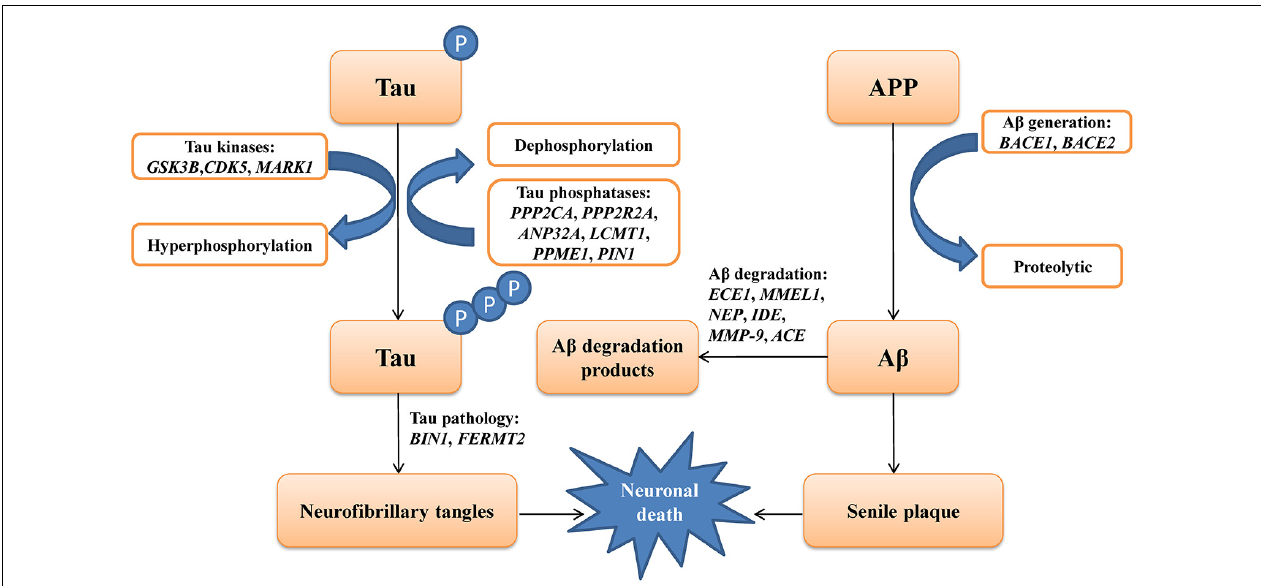
FIGURE 1 | A schematic picture showing the genes involving the metabolic pathways of amyloid- β (A β ) and tau protein in Alzheimer’s disease.